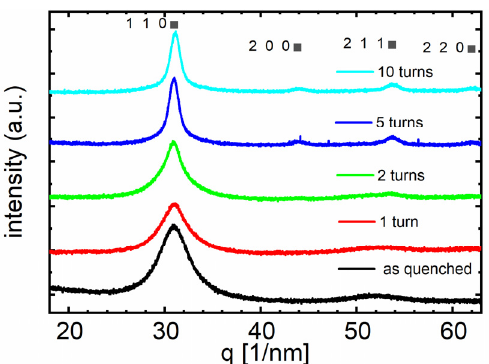
Figure 6. X-ray diffraction patterns of alloy B (Fe 81.2 Co 4 Si 0.5 B 9.5 P 4 Cu 0.8 ) before and after HPT deformation ( N = 1, 2, 5, and 10) at room temperature.